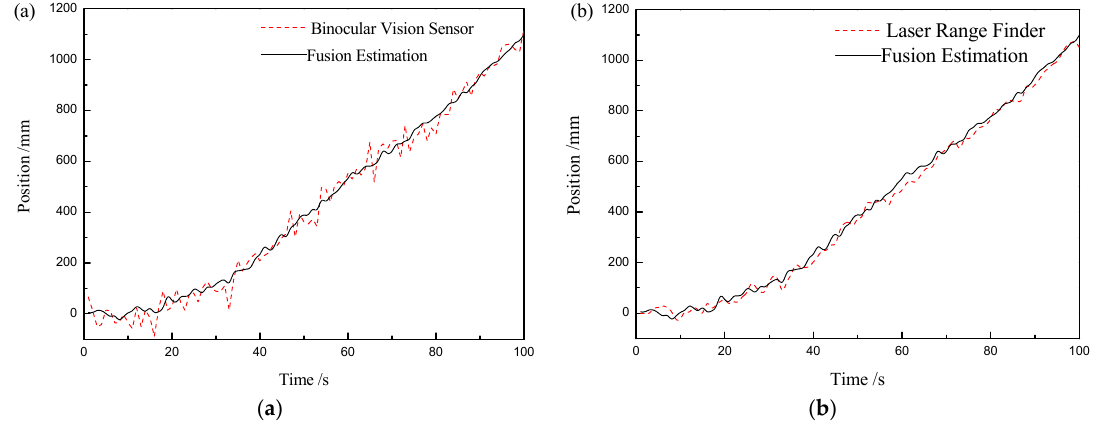
Figure 5. The tracking results for two sensors and fusion. ( a ) Tracking via the binocular vision sensor; ( b ) tracking via the laser range sensor.